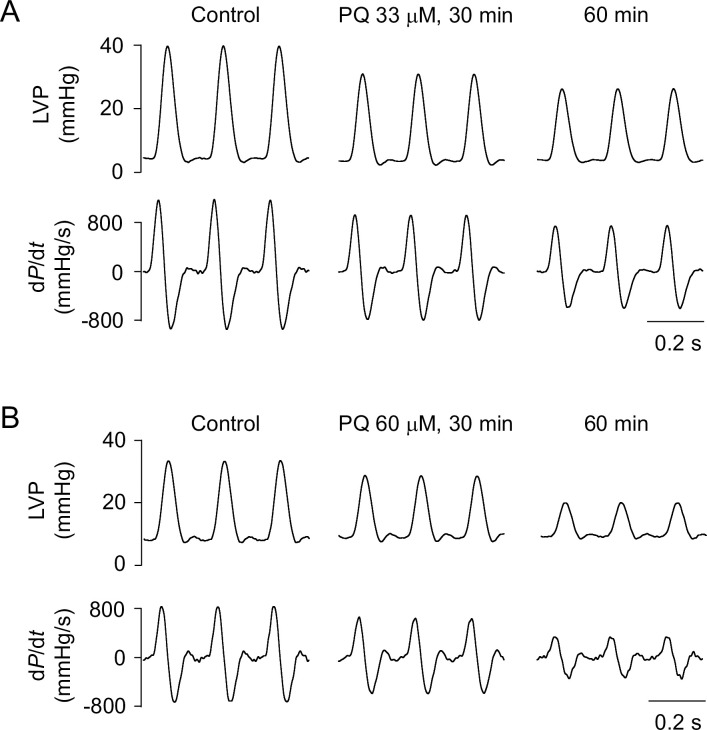
Representative tracings of LVP (upper) and dP/dt (lower) signals recorded from Langendorff-perfused rat hearts paced at 300 beats/min at baseline and following treatment with 33 μM (A) or 60 μM PQ (B).